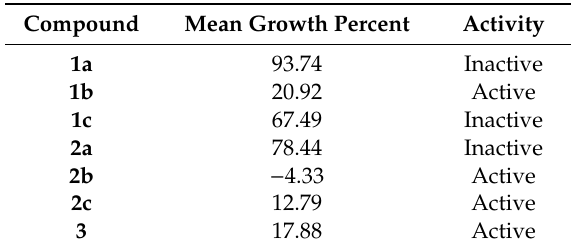
Table 1. Mean dose percent values by one-dose assay (10 − 5 M) of all the tested compounds in the full NCI 60 cell